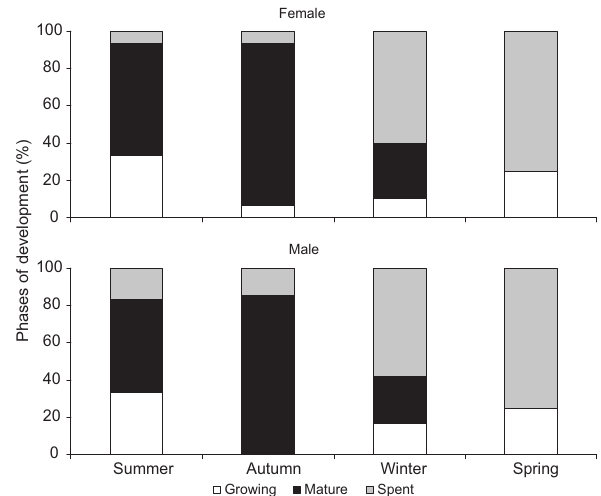
Figure 4. Seasonal variation of gonadal development phases of Echinaster ( Othilia ) guyanensis collected in southeastern Brazil (n = 12 males and 12 females per season).